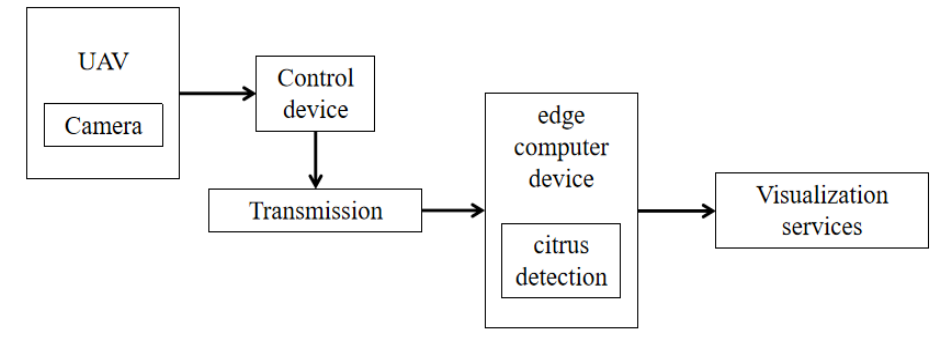
Figure 2. Citrus image shooting and transmission process.